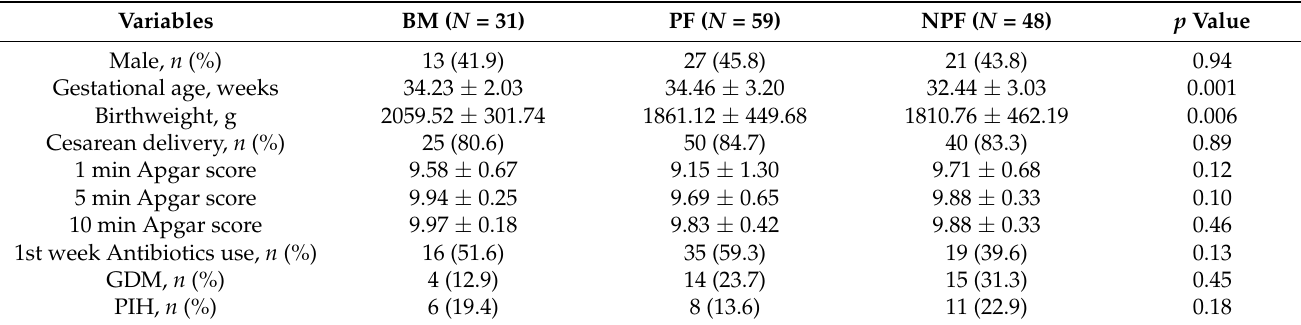
Table 1. Clinical characteristics of participants.